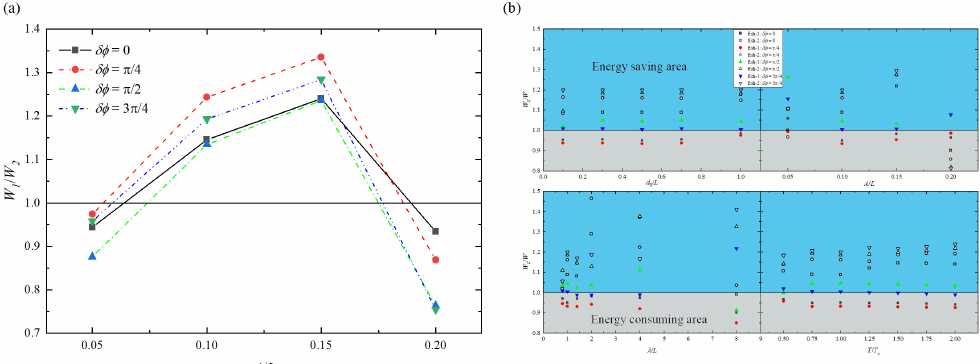
Figure 8. Ratios of mean work done by ( a ) upstream fish to rear fish and ( b ) isolated fish to two fish in a tandem arrangement with different swimming parameters: d 0 (top left), A (top right), λ (bottom left), and T (bottom right), where the W in the denominator represents the W 1 of the upstream fish and the W 2 of the rear fish, respectively. The blue block represents the energy saving-area and the gray block represents the energy-consuming